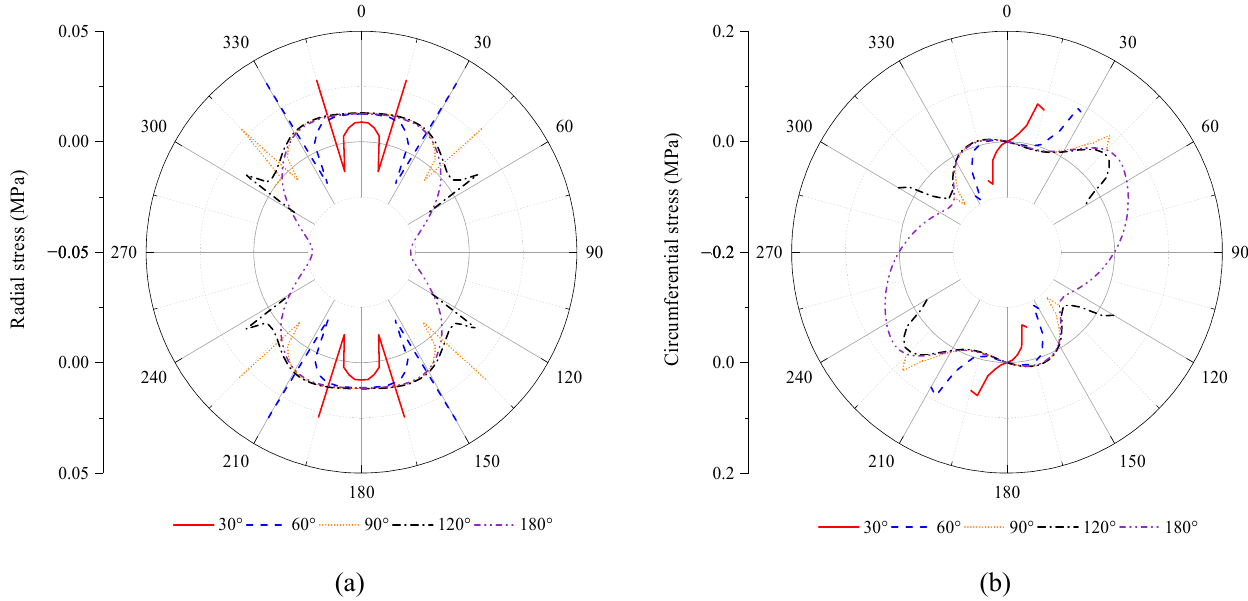
Figure 9. Effect of L on the reinforced interface stresses: ( a ) radial stress; ( b ) circumferential stress.